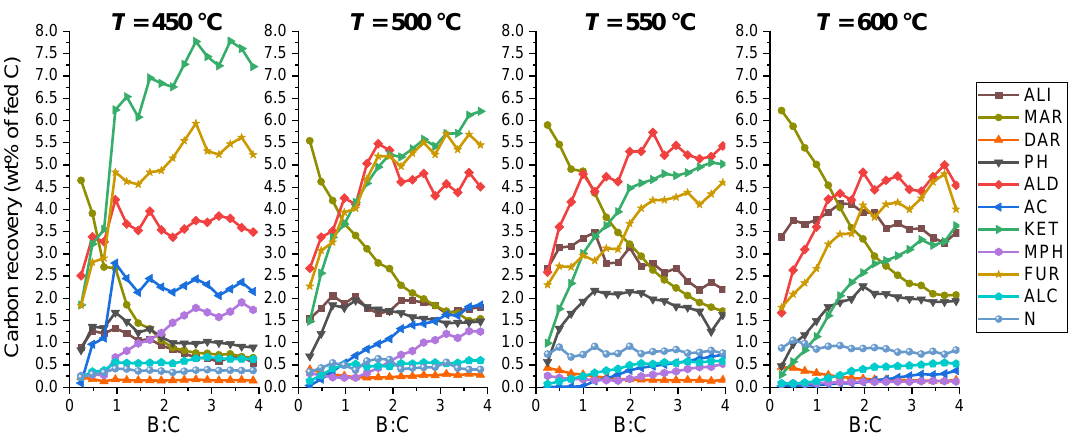
Figure 4. Carbon recovery of vapor products quantified by GC-FID when upgrading wheat straw pyrolysis vapors over P/HZSM-5/γ-Al 2 O 3 at four different catalyst temperatures. The momentary yields per biomass injection are shown. Legend applies to all graphs.